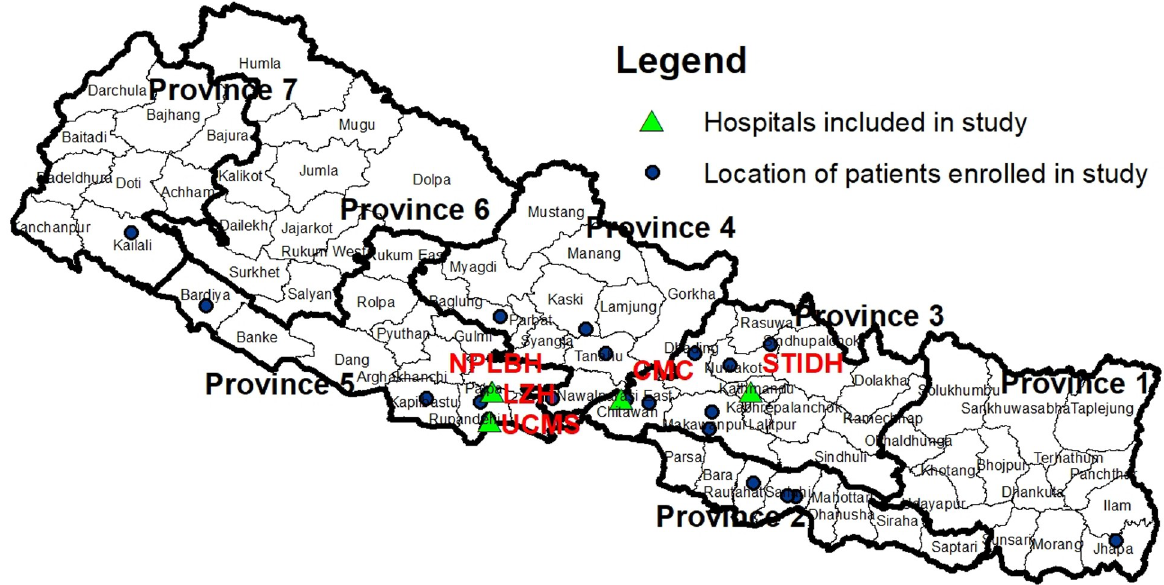
Fig 1. Distribution of the participating sites. Nepal consists of three broad terrains: the southern Terai districts, the central hill districts, and the northern mountain districts. The legends denote the hospitals where samples were collected and the districts where people got infected. The hospitals were: “Sukraraj Tropical and Infectious Disease Hospital (STIDH)”, Kathmandu; “Chitwan Medical College and Teaching Hospital (CMC)”, Chitwan; “Universal College of Medical Science (UCMS)”, Bhairahawa; and three hospitals in Butwal: “Lumbini Zonal Hospital (LZH)”, “Butwal Hospital (BH)” and “National Path Lab (NPL)”. Prepared using Arcmap 10.3 [21] with spatial data obtained from the Government of Nepal official website http://drm.moha.gov.np/ [22].